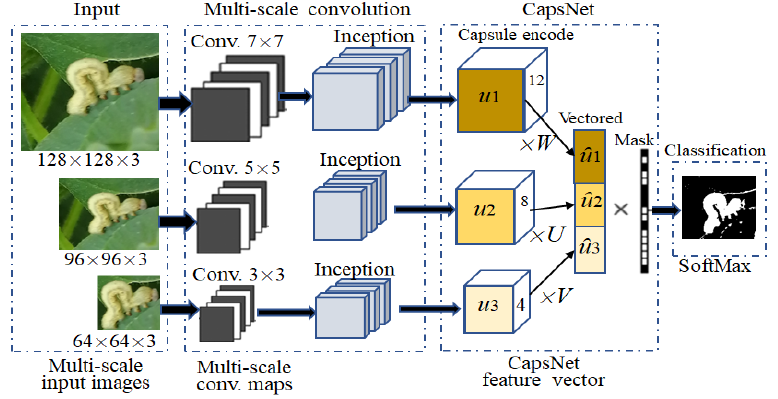
Figure 4. Architecture of MSCCN.